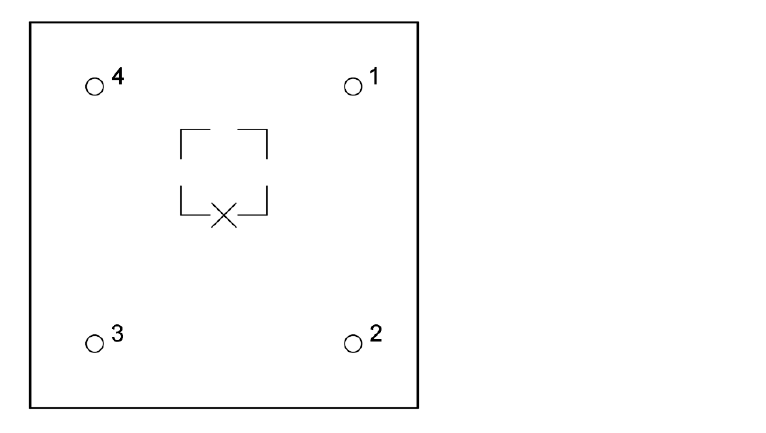
Figure 11. Scheme of void and IE device layout, edge below impactor. Table 5. Integral and RMS of frequency spectrum, edge below impactor.